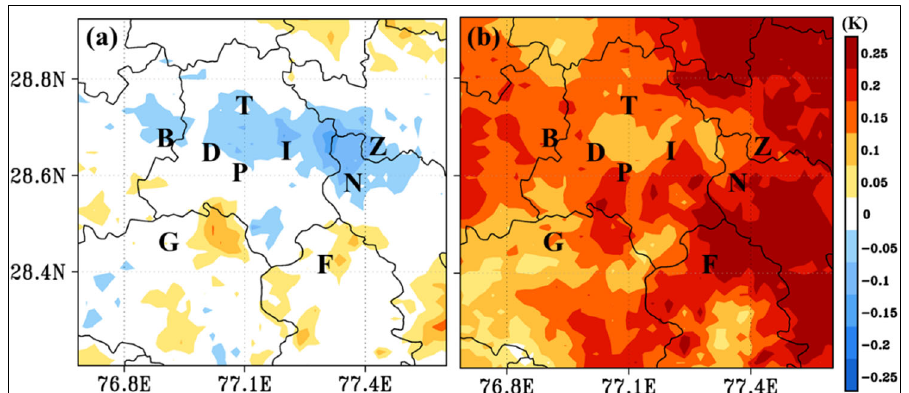
Figure 5. Spatial plots of ( a ) difference of temperature values (K) between case with direct feedback and no feedback (Case B—Case A). ( b ) Difference of temperature values (K) between case with direct and indirect feedback and no feedback (Case C—Case A) over NCT. (P: Punjabi Bagh, D: Dwarka, I: ITO, T: DTU, N: Noida, Z: Ghaziabad, F: Faridabad, G: Gurugram and B: Bahadurgarh).